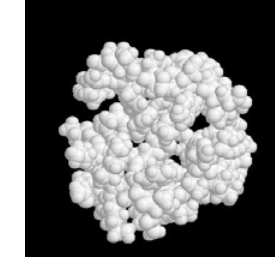
Figure 2. Comparison between the native structure and a swelling structure featuring the pressure-induced